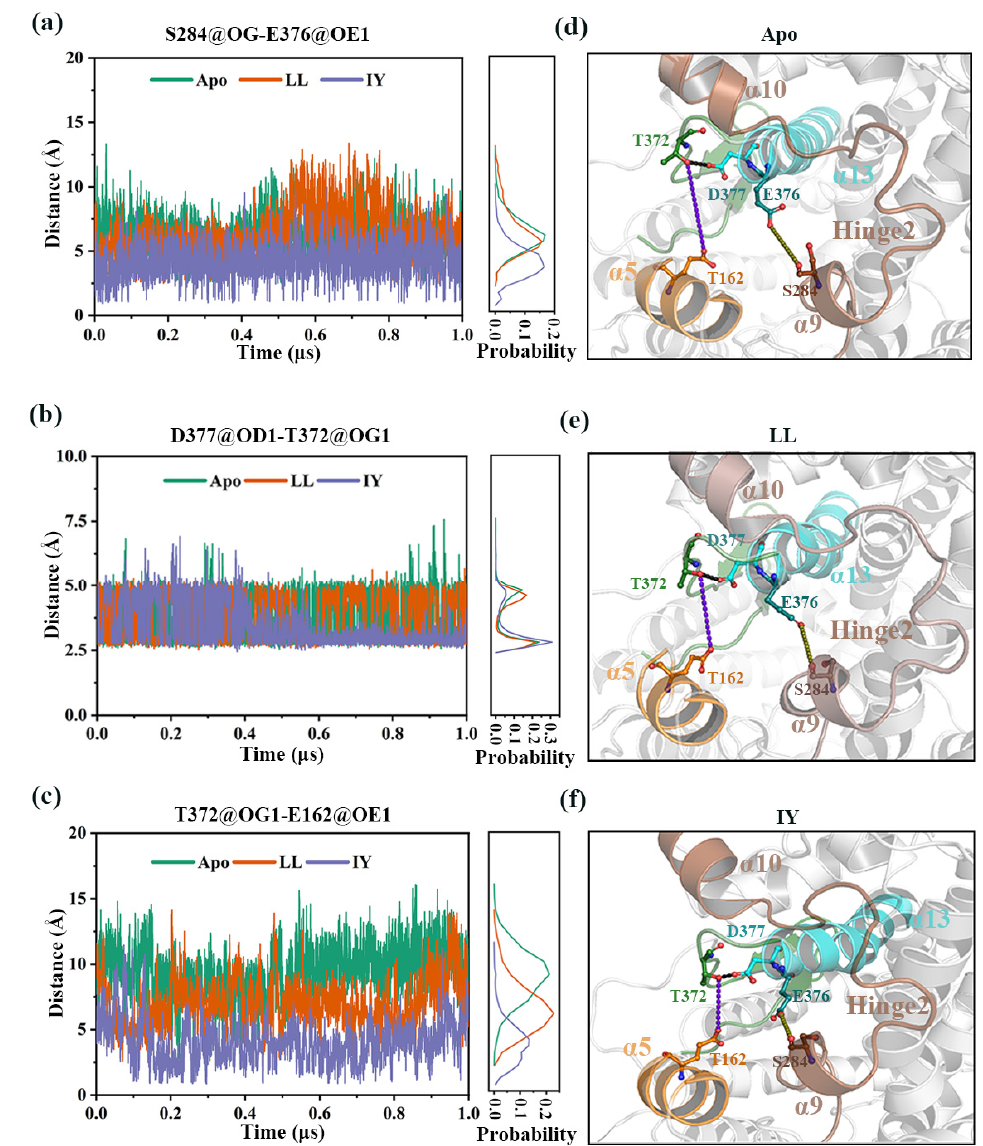
Figure 11. Interactions affecting the active site in ACE upon binding of LL and IY. The hydrogen bonding between different residues, such as ( a ) S284–E376, ( b ) D377–T372, and ( c ) T372–E162, are shown; the schematic diagrams highlighting the critical interactions for ( d ) Apo, ( e ) ACE–LL, and ( f ) ACE–IY. Apo means ligand-free protein, ACE–LL represents the complex system of protein and dipeptide Leu-Leu, ACE–IY stands for complex system of protein and dipeptide Ile-Tyr.